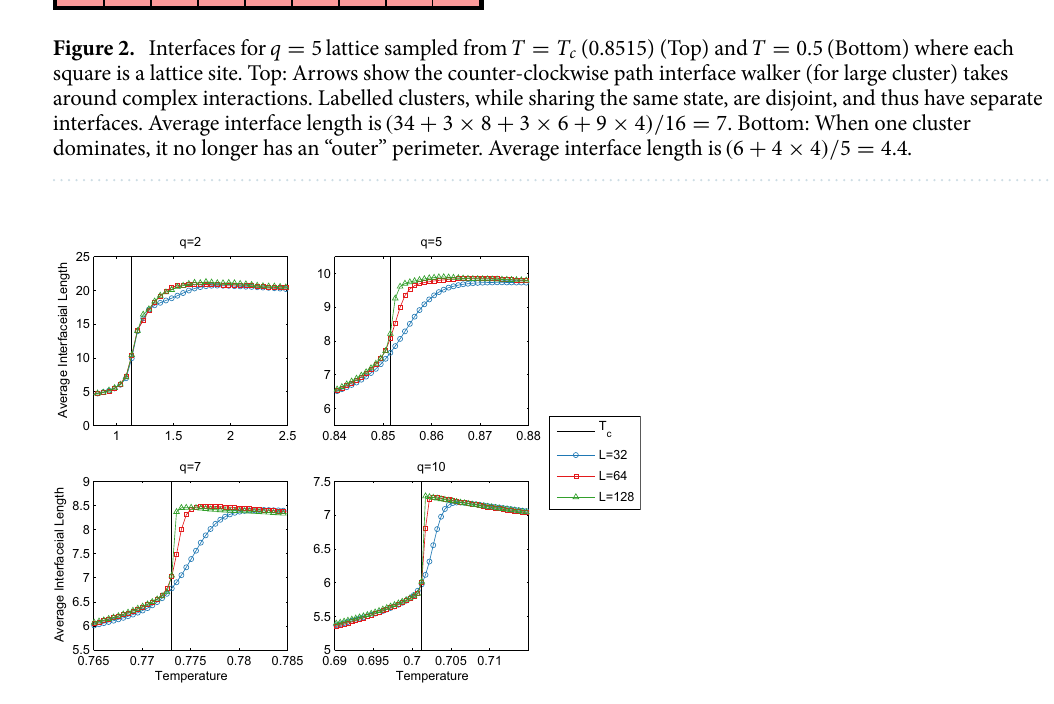
2, 5, 7, 10 for indicated lattice sizes. The behaviour in ∈ { } 5, 7, 10 , converge to ∈ { } 2 remains = 2 and Ising results is =